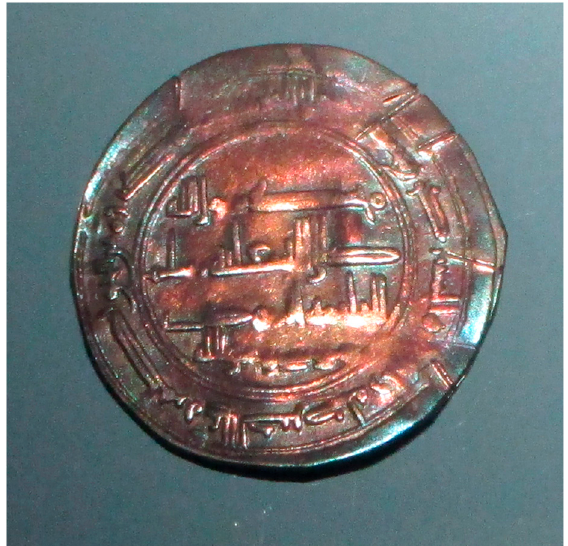
Figure 3. The Khazar ‘Moses’ Coin, from the Spillings Hoard, Gotland Museum © W. Carter (CC BY-SA 4.0 license).